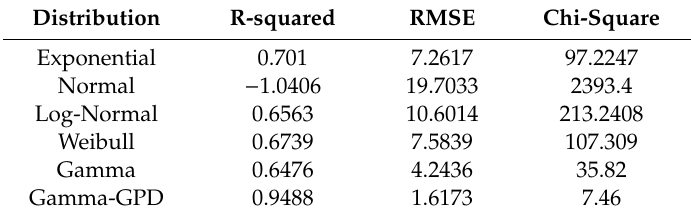
Table 5. The goodness of fit of various models under current conditions (drought duration).